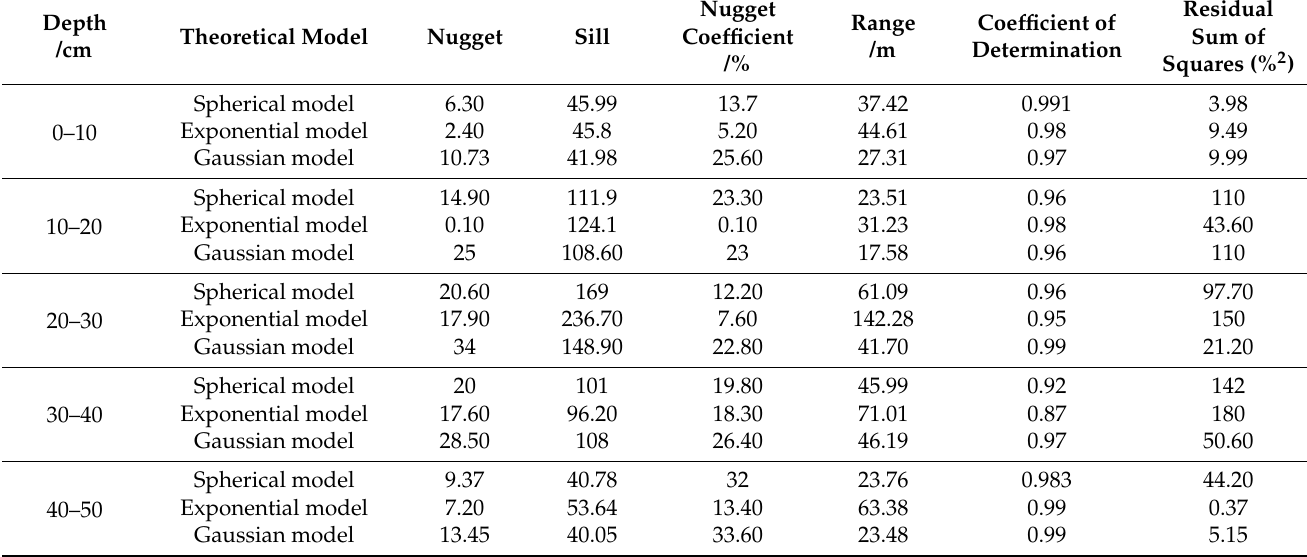
Table 3. Theoretical semi-variogram models of soil moisture and its related parameters.